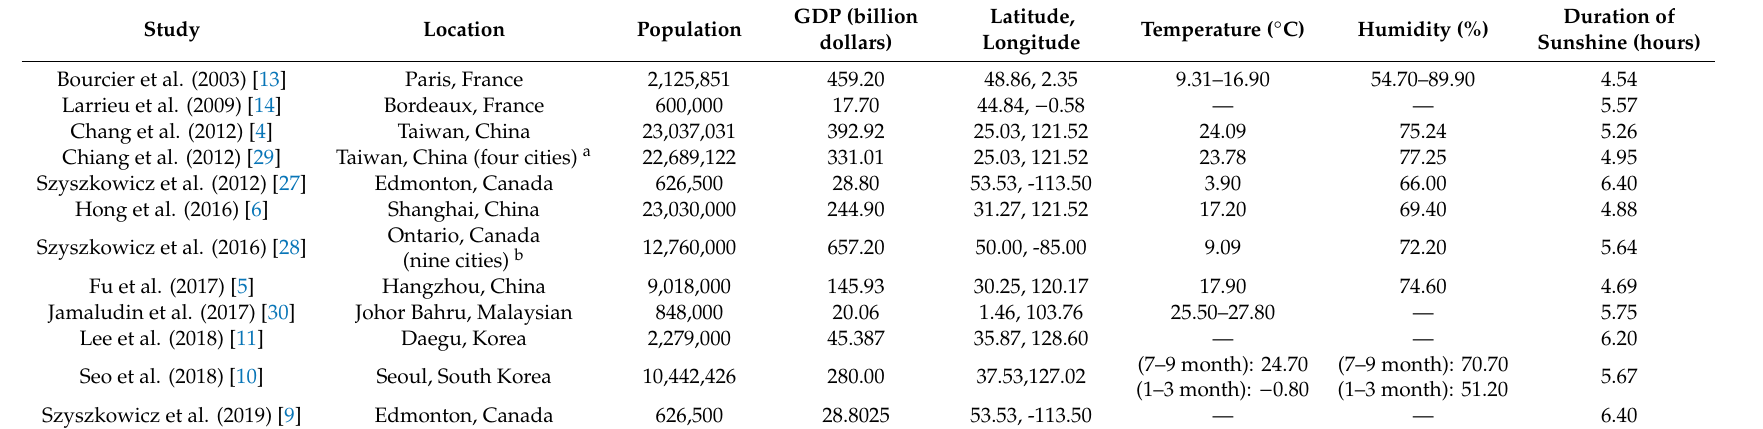
Table A2. Supplementary information of the included literature.